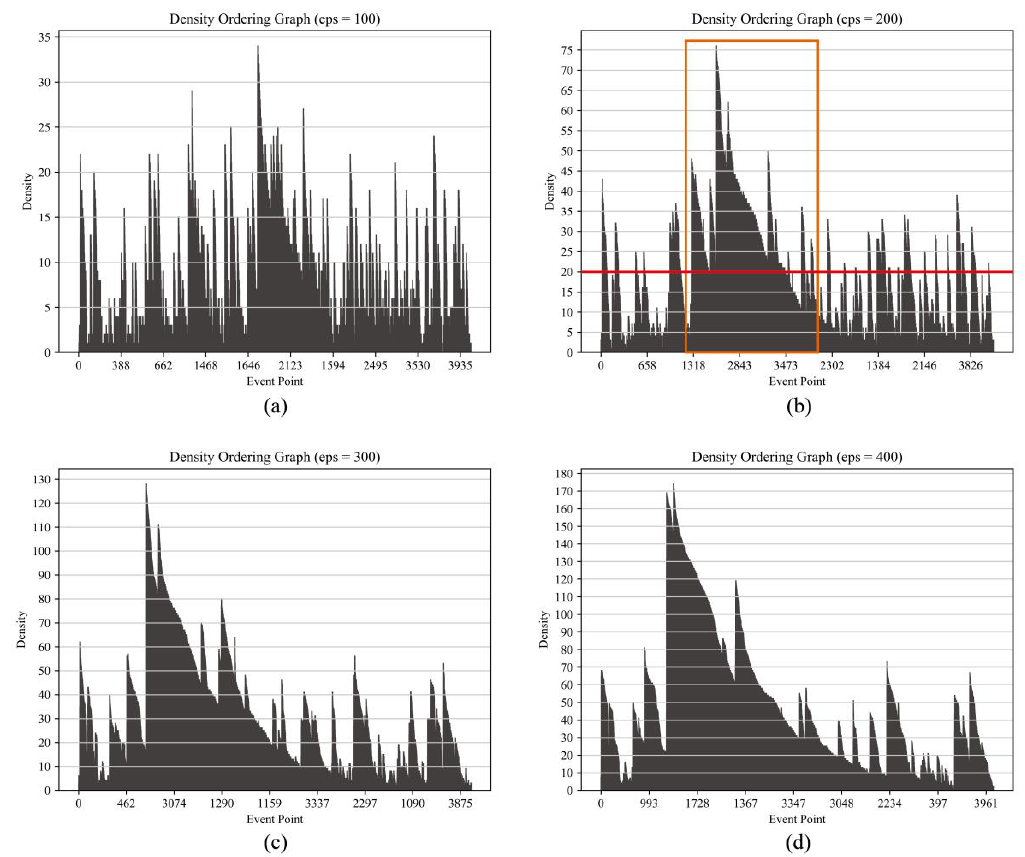
Figure 12. Density ordering graphs of ( a ) eps = 100; ( b ) eps = 200; ( c ) eps = 300; and ( d ) eps = 400.